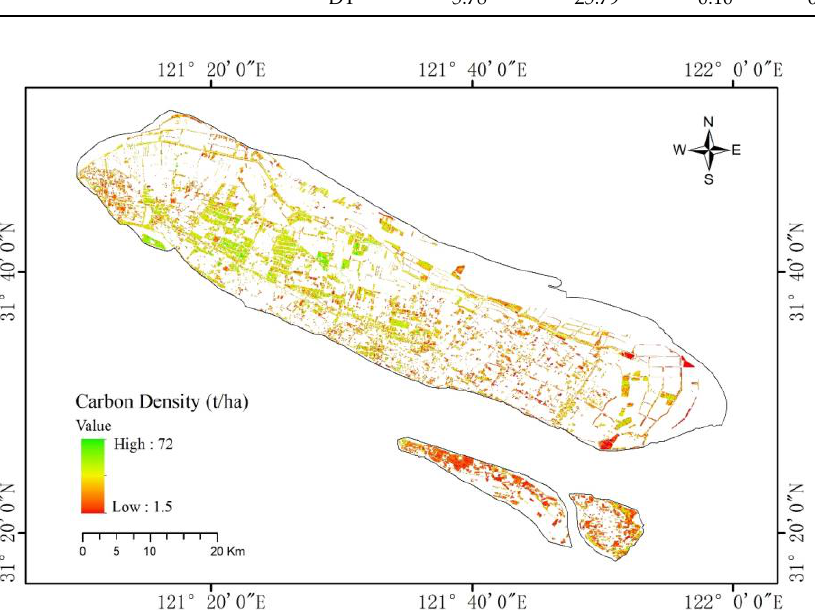
Figure 3. Spatial distribution of the forest carbon density at the all-forest classification scale on Chongming eco-island. Table 4. Average forest carbon density (t/ha) and carbon storage across Chongming eco-island (three islands) at the scales of different forest types and dominant tree species. EBLF: evergreen broad-leaved forest, DBLF: deciduous broad-leaved forest, and WCF: warm coniferous forest.